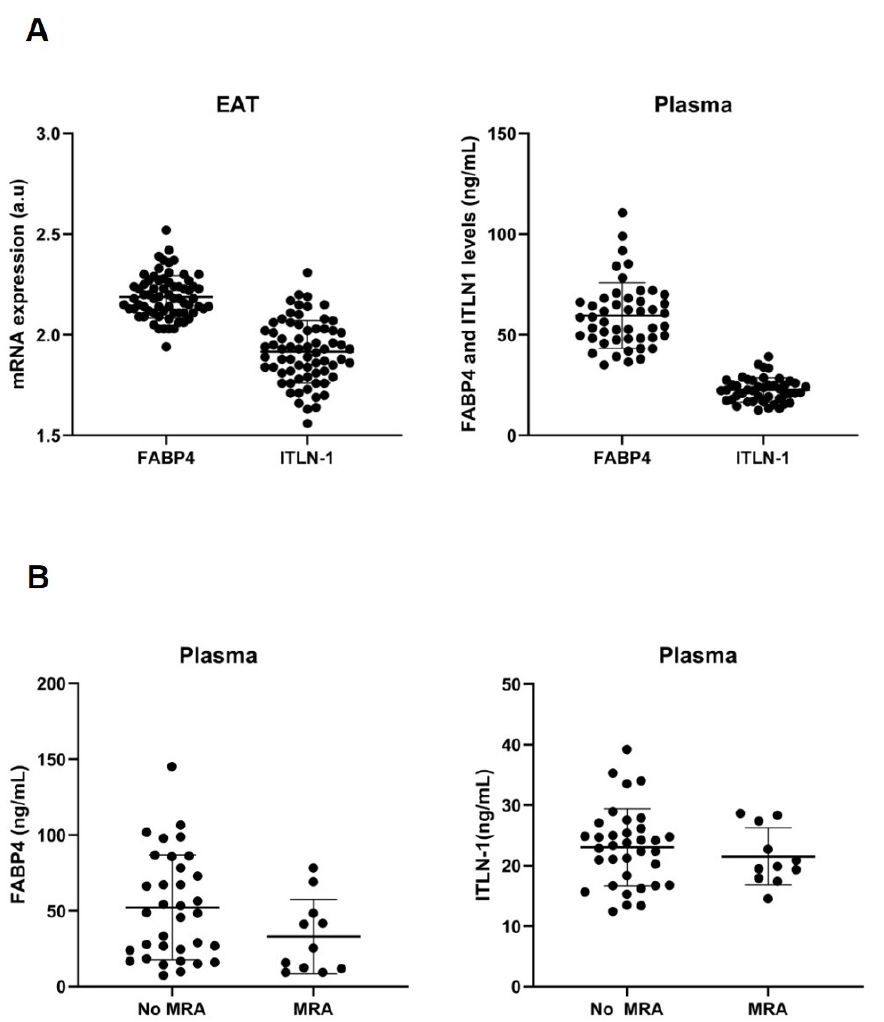
Figure 4. MRA on FABP4, CD36 and ITLN-1 ( A ) Dot plots and mean ± SD represent the mRNA